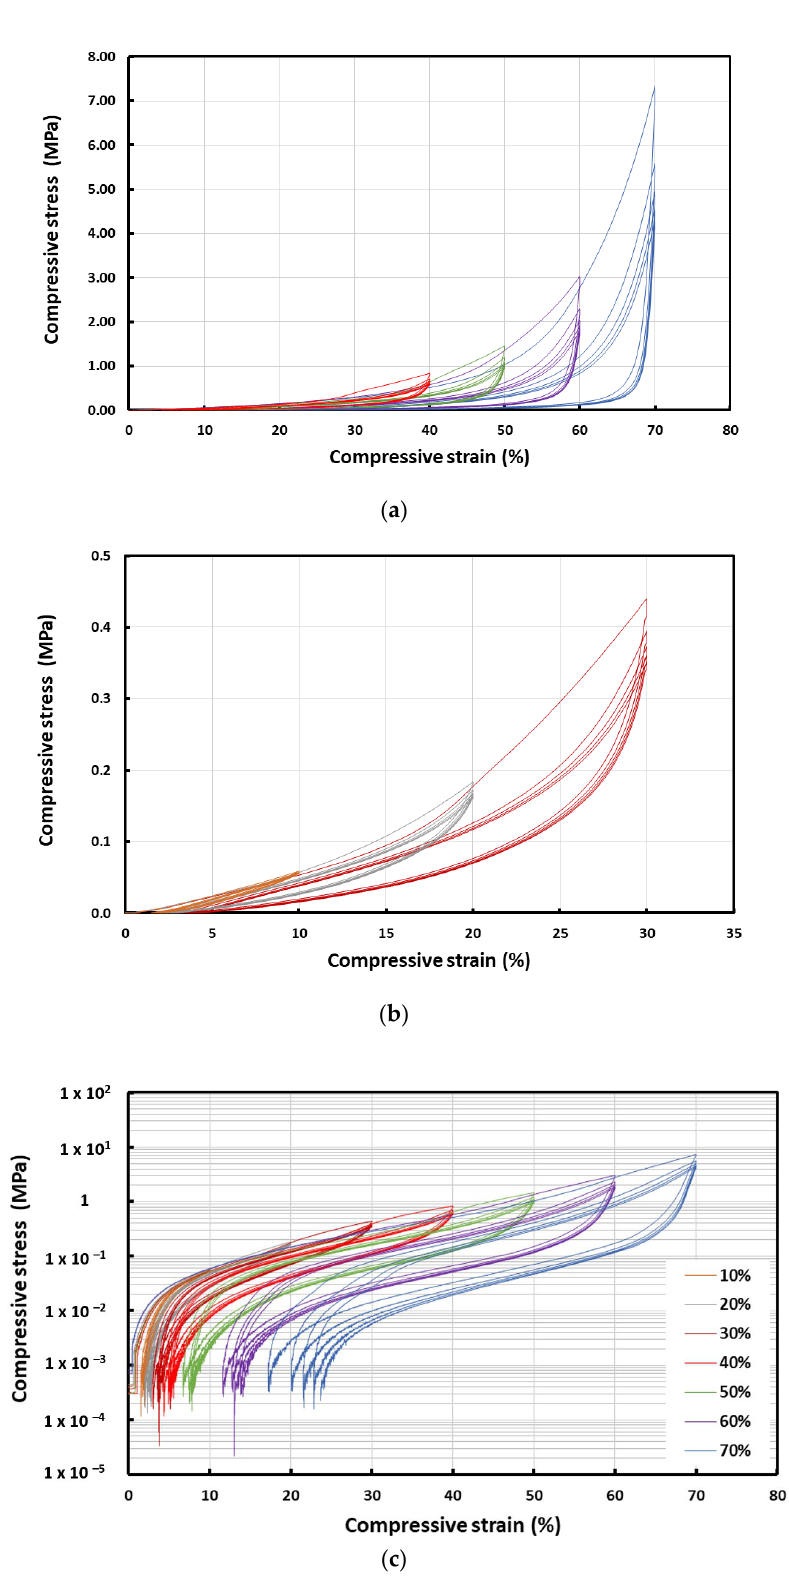
Figure 2. Typical stress vs. strain curves of cylindrical sample in cyclic uniaxial compression at room temperature ( a ) from 10% to 70% strain with an increment of 10% at each step; ( b ) zoomed in portions of the initial part of the curves at 10%, 20% and 30% strains; ( c ) logarithmic curves showing the residual